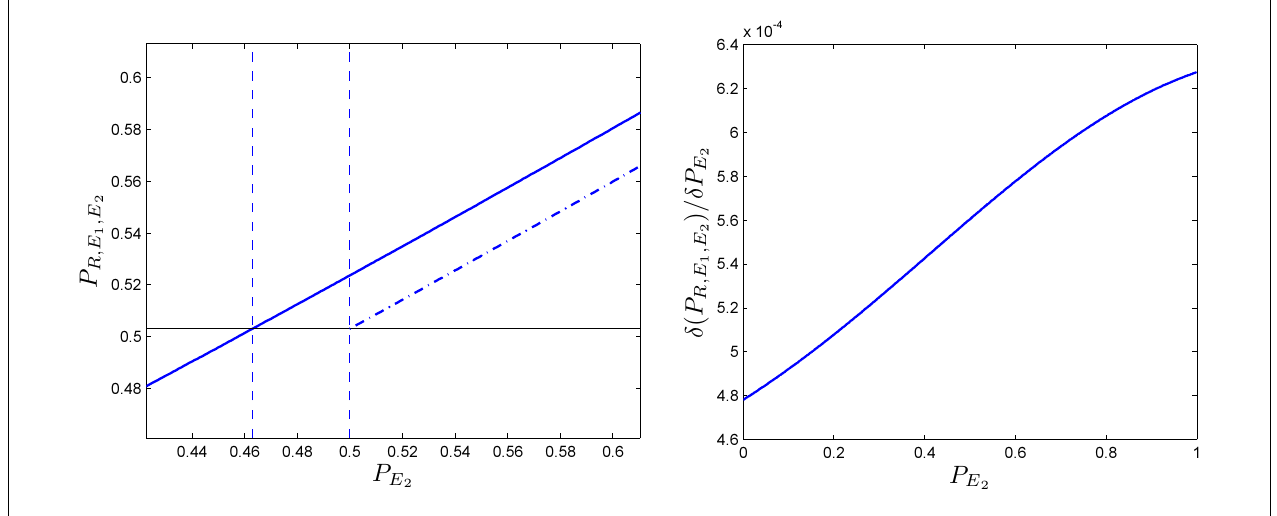
line) vs. the linear case (dotted line). Besides the trivial increasing line, the function is slightly curved. (Right side): its derivative function with respect to P E , denoted by δ( PRE 1 E 2 ) , allows us to observe the effect enlarged. δ( PE 2 ) 2